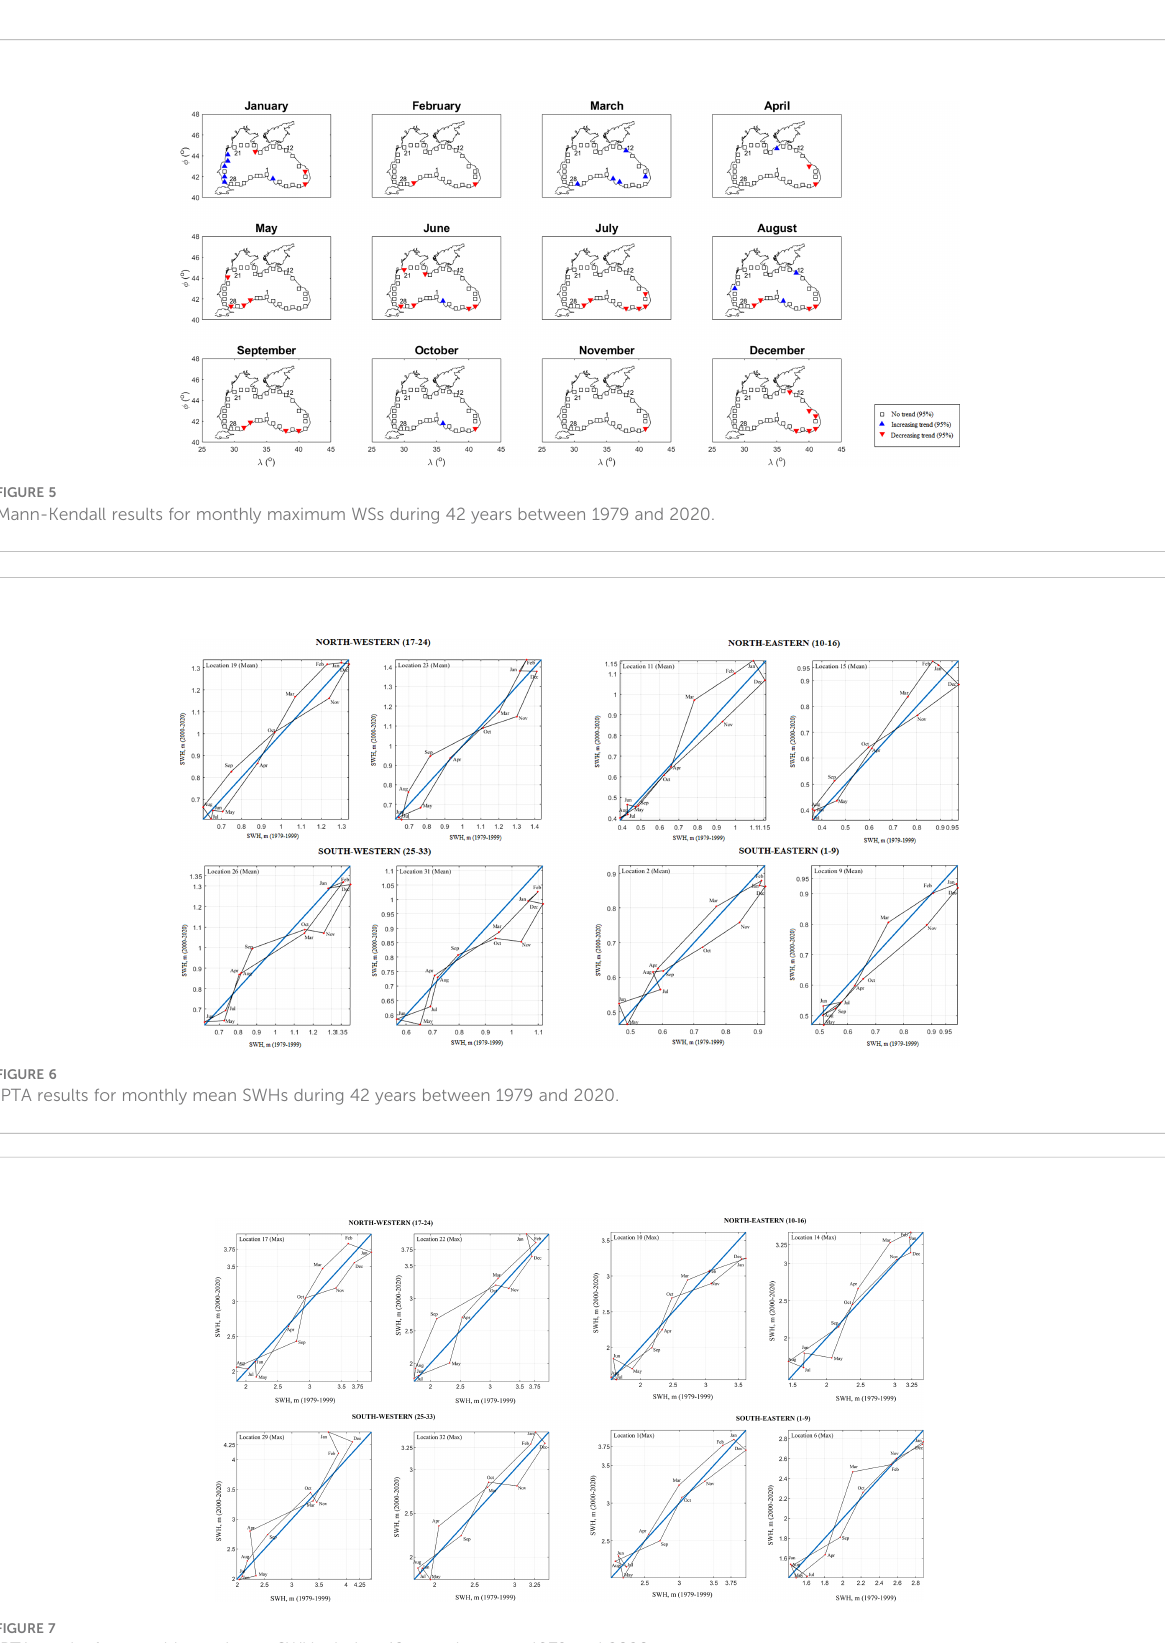
FIGURE 7 IPTA results for monthly maximum SWHs during 42 years between 1979 and